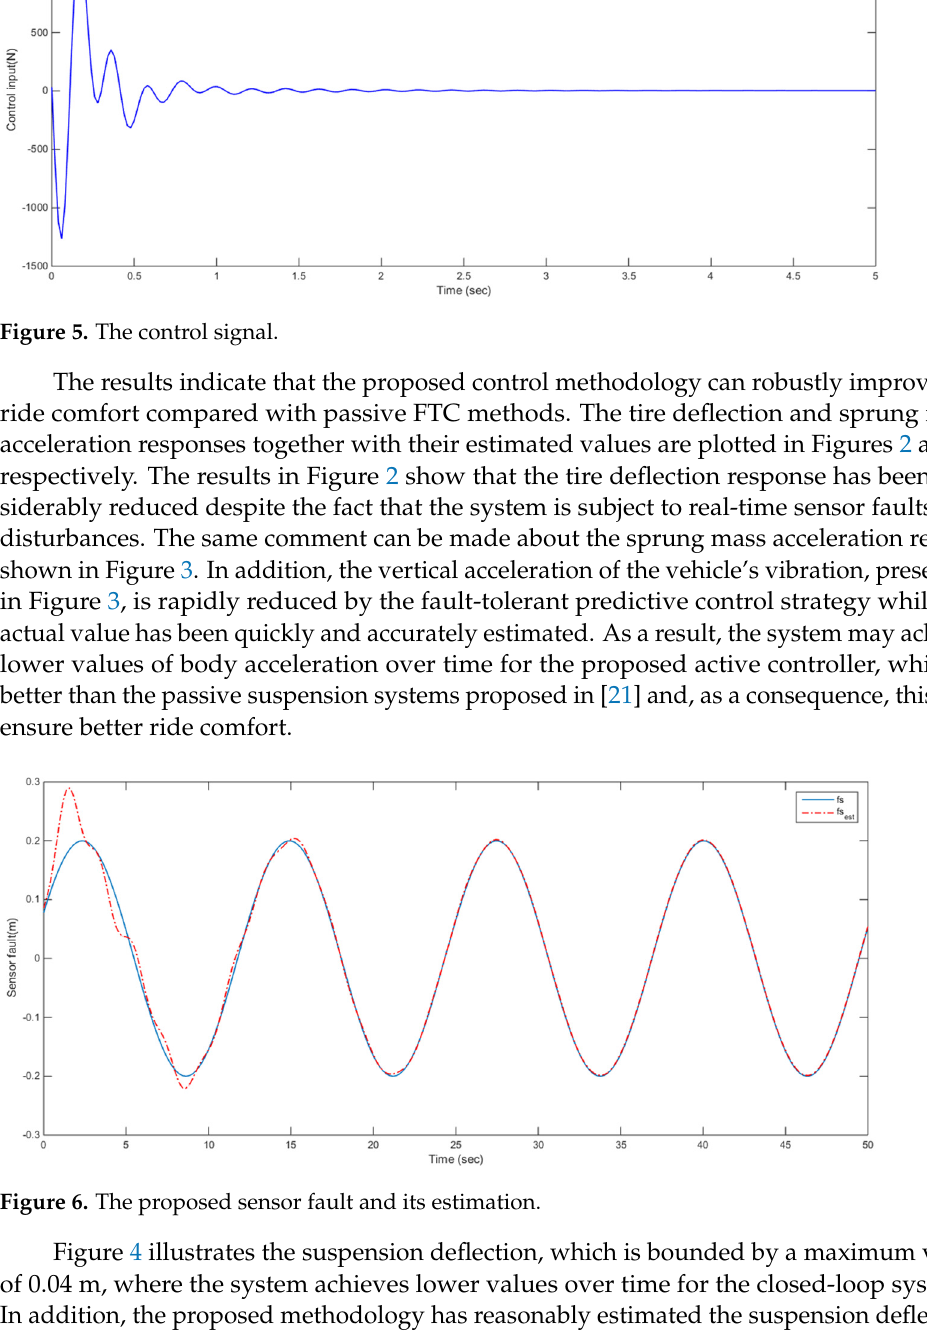
Figure 4. The step response of the actual and estimated suspension deflection.